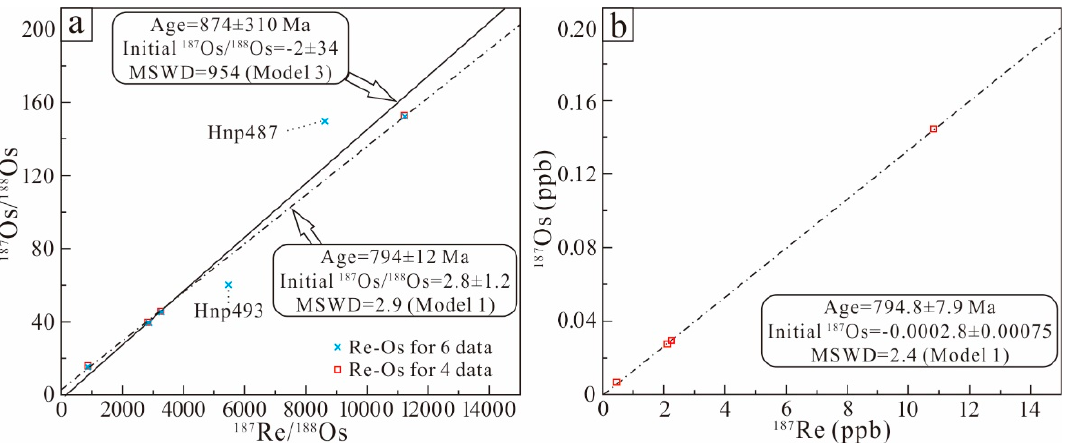
Figure 7. ( a ) 187 Re / 188 Os vs. 187 Os / 188 Os plot and ( b ) 187 Re vs. 187 Os plot of chalcopyrite from vein-type ores in the Hongnipo copper deposit.